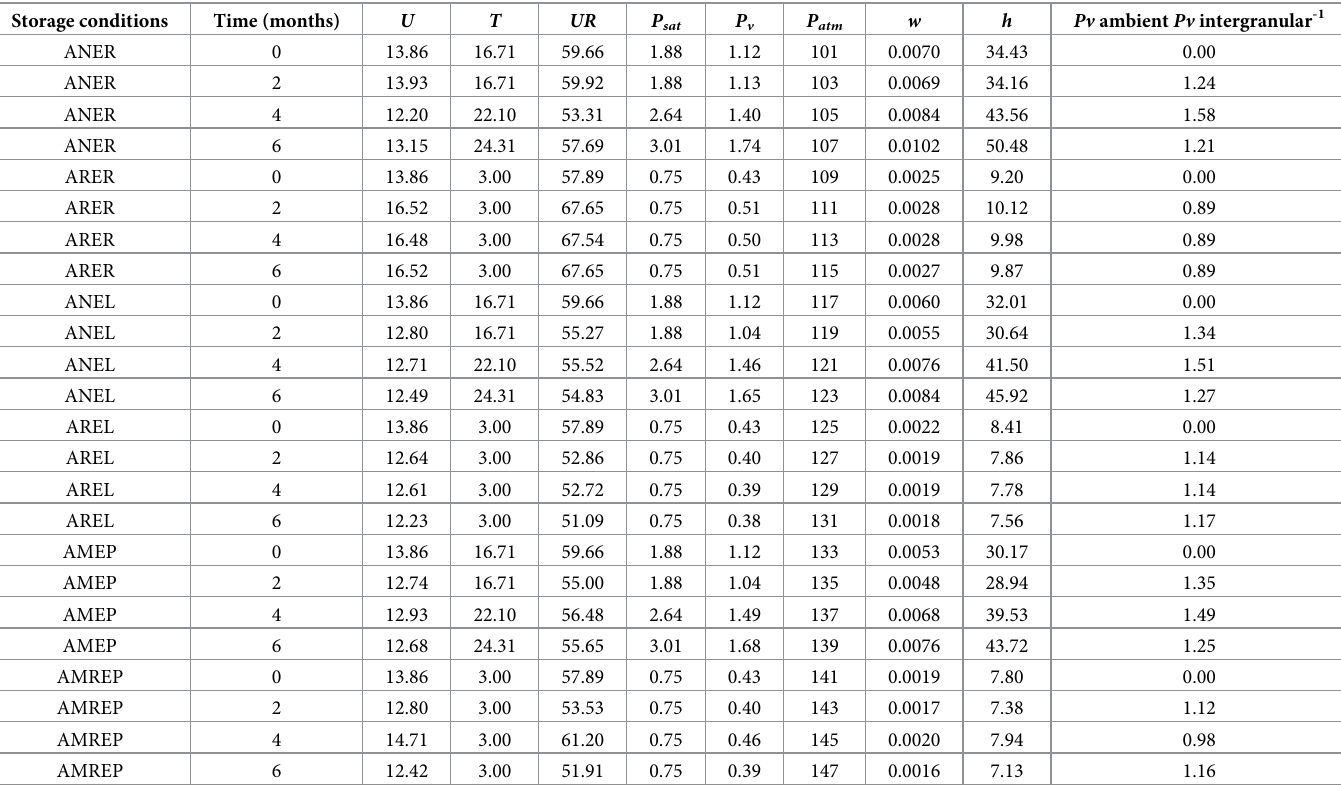
Table 4. Characterization of RR2 soybean seeds and conditions storage. Storage conditions